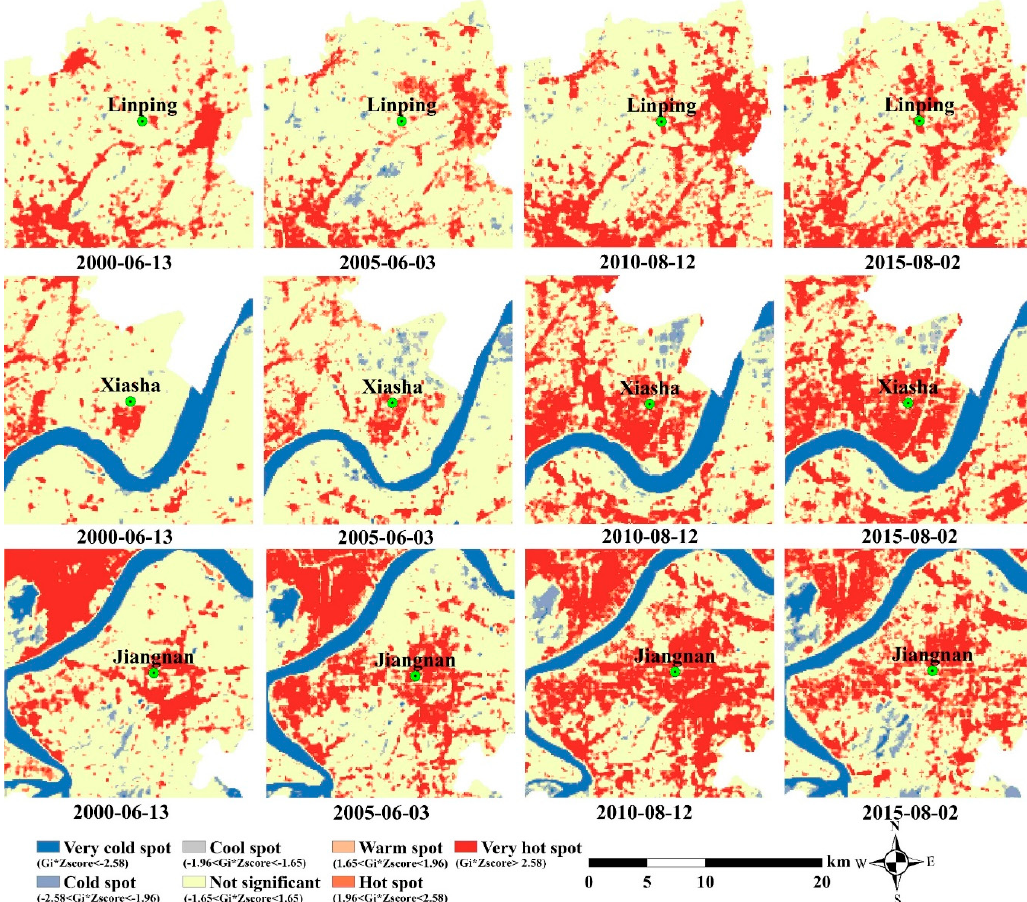
Figure 4. SUHI evolution of three satellite towns. Remote Sens. 2019 , 03 , x FOR PEER REVIEW